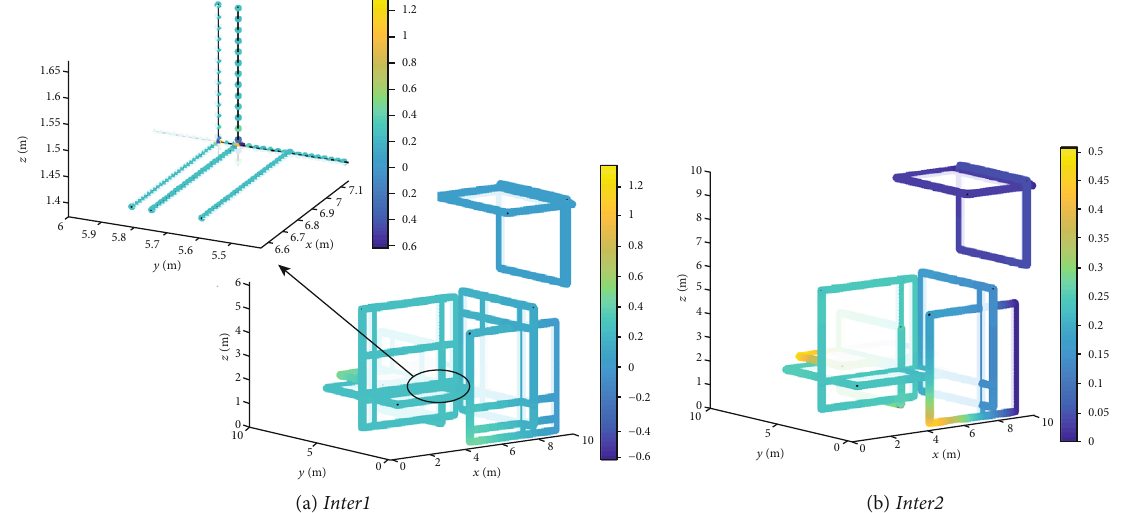
Figure 9: Hydraulic head distribution on the discretization nodes for the con fi guration Con fi g_4b (Figure 7(b)) using the methods (a) Inter1 and (b) Inter2 for de fi ning the subfractures of the system. In (a), the illustration enlargement shows instabilities of the hydraulic head that are related to the presence of small subfractures, whereas these instabilities are not observed in